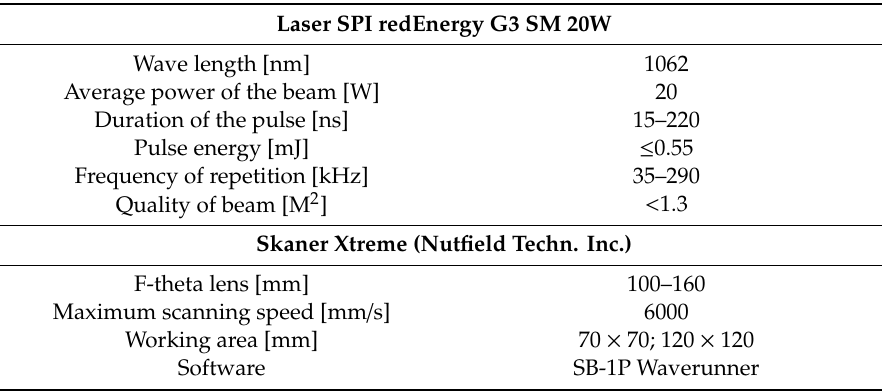
Table 1. Parameters of the devices of the laser system.